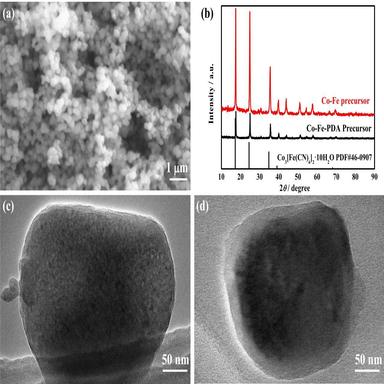
(a) SEM image of Co-Fe precursor; (b) XRD of Co-Fe precursor and Co-Fe-PDA precursor; TEM image of (c) Co-Fe precursor and (d) Co-Fe-PDA precursor.